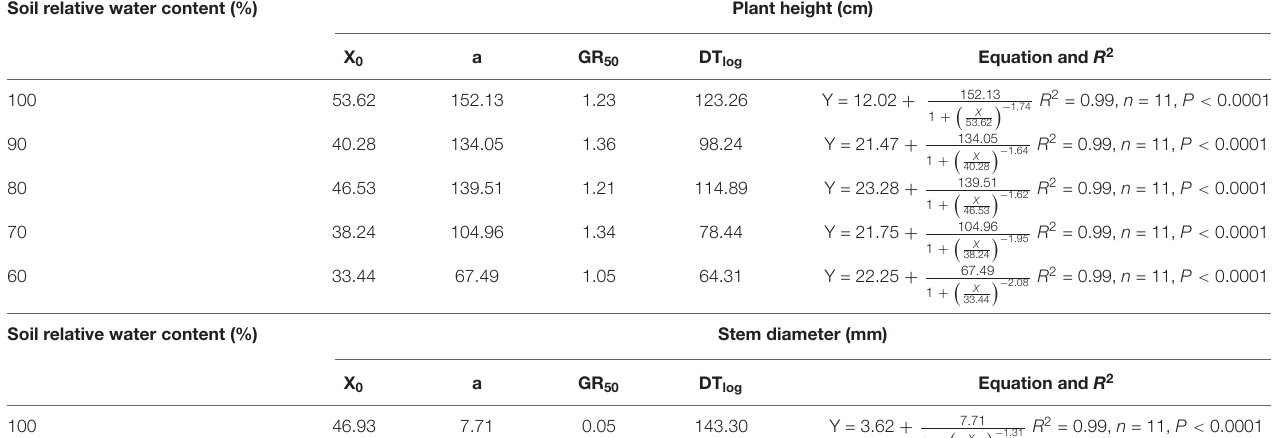
TABLE 2 | Fitting equations of the relationship between growth indices and time (d). Soil relative water content (%)